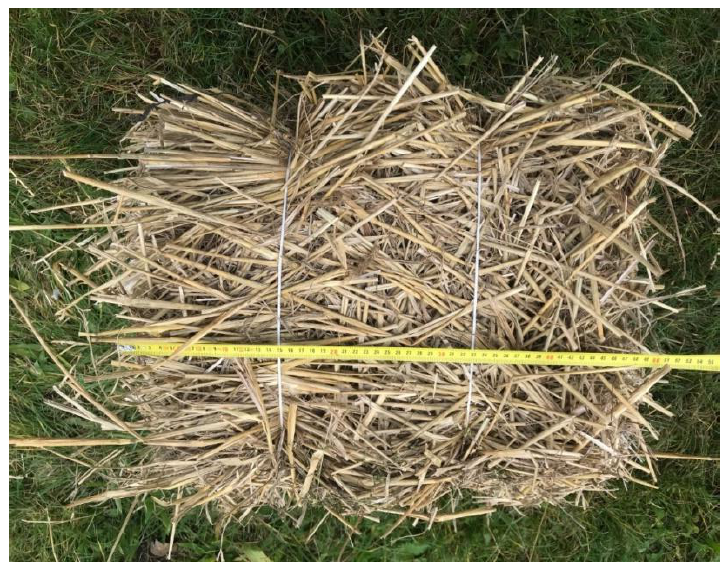
Figure 1. A straw bale designed for use in construction.